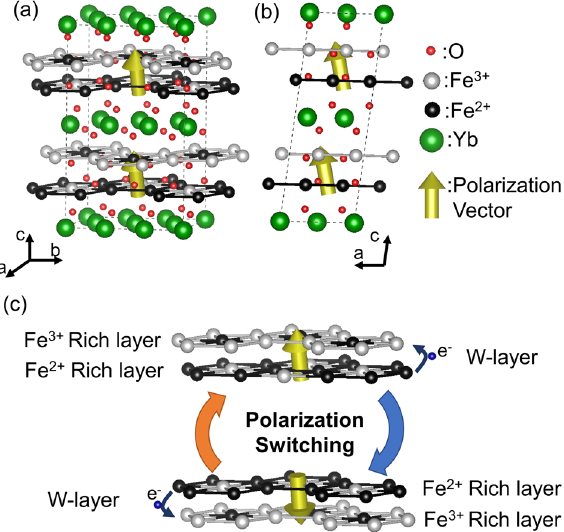
Figure 4. ( a ) Schematic representation of the crystal structure for the Fe 2+ (black circles) and Fe 3+ (gray circles) ordering in YbFe 2 O 4 , as expected from the SHG and neutron diffraction measurements. The dotted lines represent the monoclinic unit cell and the red and green colored circles represent the locations of O and Yb, respectively. The yellow arrows denote the polarization direction, which is tilted 16.5° from the [001] h . ( b ) Projection of the crystal structure onto the (010) m plane, where the polarization tilt direction can be more clearly resolved. ( c ) Schematic view of the polarization switching due to electron hopping within the W-layers. The possible directions of electron (e − , small blue circles) hopping are labeled with small blue arrows. The large orange and blue arrows represent polarization switching. There crystal structure was drawn by VESTA 3 software 27